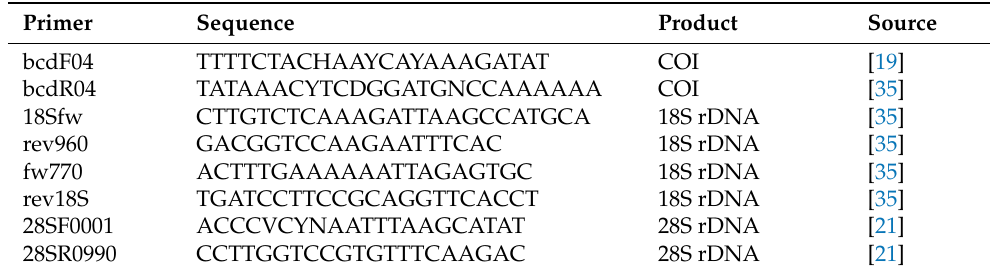
Table 1. Primers used in this